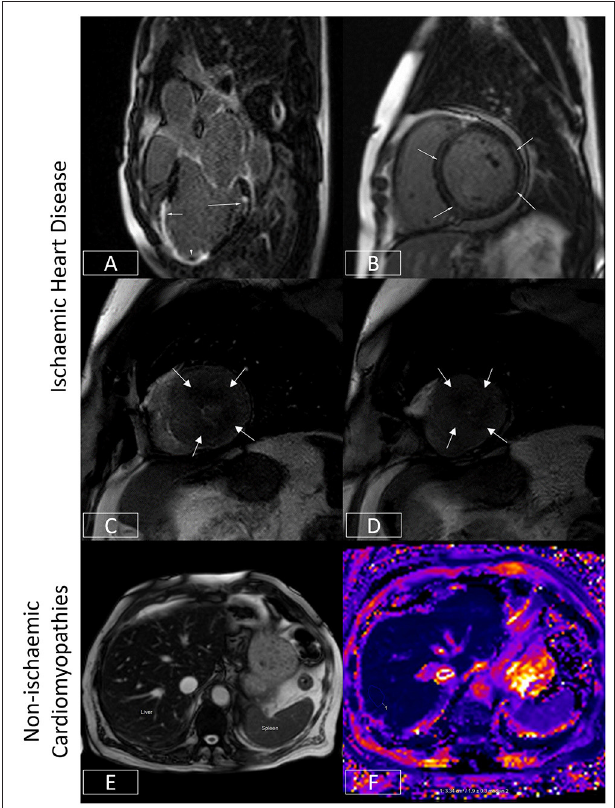
FIGURE 4 | Ischaemic and non-ischaemic heart disease. (A) Late gadolinium enhancement sequence in the 3-chamber view. There is near transmural sub-endocardial enhancement of the mid-apical septum and apex (short arrow, mid-left anterior descending coronary artery territory). A signal void focus is also seen adherent to the apex (arrowhead). This represents a left ventricular thrombus. In addition, there is focal partial thickness sub-endocardial enhancement of basal inferolateral wall (long arrow, circumflex coronary artery territory), which spares the sub-epicardium (denoting an ischaemic etiology). The presence of infarcts in two different coronary territories alludes to the potential presence of multivessel coronary disease. (B) Late gadolinium enhancement sequence demonstrating a ring or circumferential pattern of non-ischaemic enhancement. The areas of enhancement involve the mid-wall or sub-epicardium, sparing the sub-endocardium. (C,D) Stress perfusion scan from a patient with hypertrophic cardiomyopathy. There is widespread circumferential sub-endocardial delayed arrival of contrast (hypoperfusion) at mid-ventricular level (C) and apex (D) , typical of microvascular dysfunction. (E,F) Bright blood axis scout at upper abdominal level (E) . The normal liver should have signal characteristics similar to the spleen (marked). However, in this patient with hepatic iron overload, the spleen appears almost black due to accelerated dephasing of spins brought about by the increasing field inhomogeneity generated by intrahepatic iron stores. This T * 2 effect can be used to quantify liver iron levels (F) . Here, the liver T * 2 is ∼ 1.9ms, denoting moderate hepatic iron overload (normal > 6.3ms) equivalent to ∼ 5–10mg iron/g dry